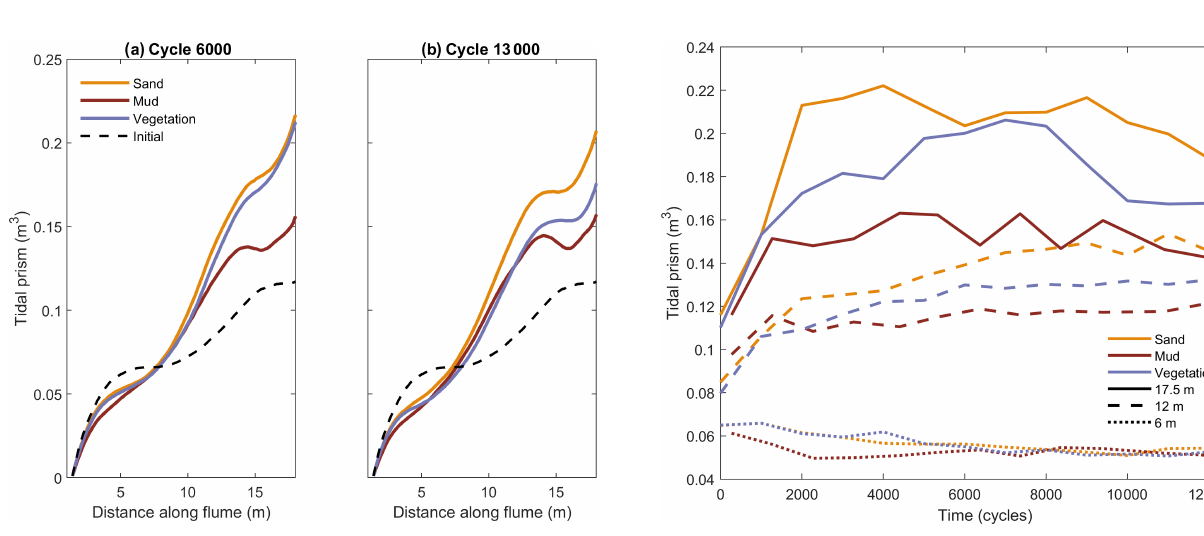
Figure 11. Time series of tidal prism calculated along the estuaries at distances of (a) 6m, (b) 12m and close to the mouth at (c)